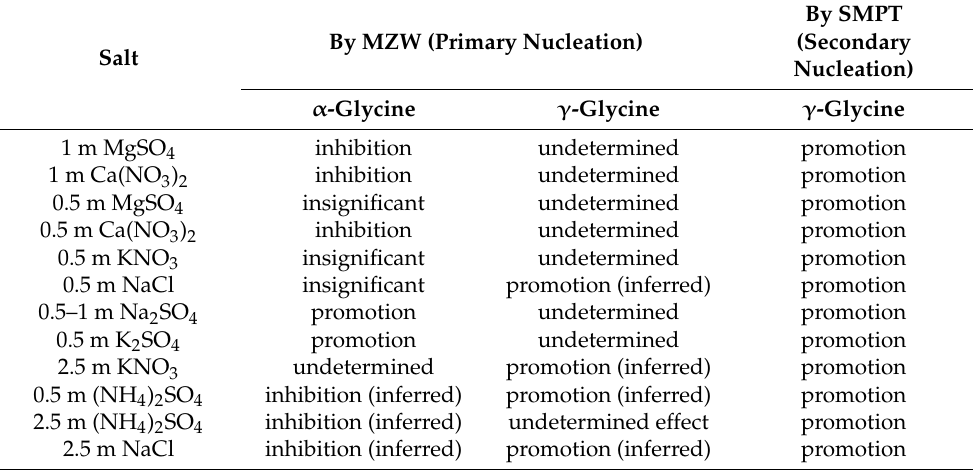
inhibition (inferred) promotion (inferred)